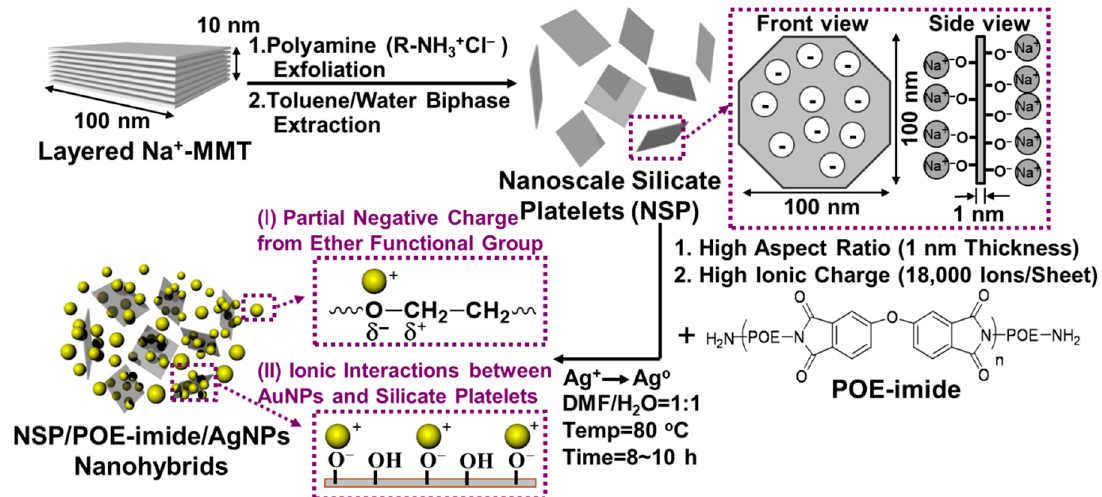
Scheme 2. Schematic of the exfoliation process for the layered Na + -MMT clay into exfoliated silicate nanosheets and illustration of the surface ionic charges. The polymeric dispersant and silicate are attracted to Ag + ions, resulting in well-dispersed AgNPs. A schematic of the dispersion mechanisms of the AgNPs/nanoscale silicate platelets (NSPs) and AgNPs/POE-imide stabilizations are also shown.